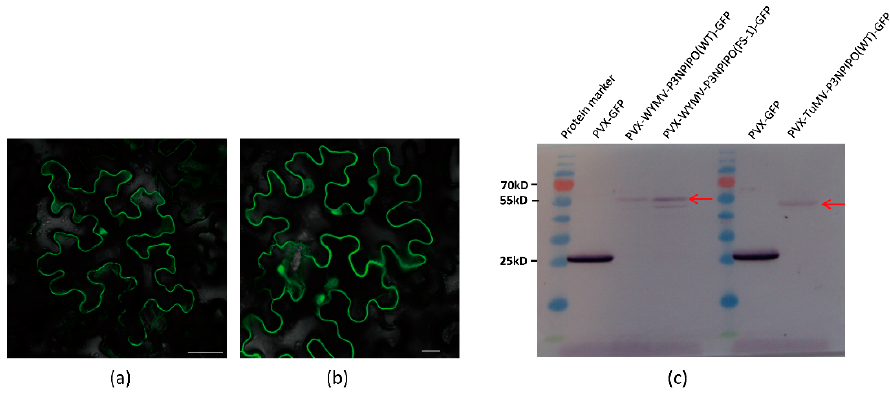
Figure 2. Frameshift expression of P3N-PIPO(WT) in N. benthamiana leaf cells. ( a ) PVX-TuMV-P3N- PIPO(WT)-GFP expressed in the epidermal cells treated eight days post-agroinfiltration. ( b ) PVX- WYMV-P3N-PIPO(WT)-GFP expressed in the epidermal cells treated eight days post-agroinfiltration. Bars, 50 µ M. ( c ) Immunodetection of the frameshift expression of PVX-TuMV-P3N-PIPO(WT)-GFP and PVX-WYMV-P3N-PIPO(WT)-GFP in N. benthamiana